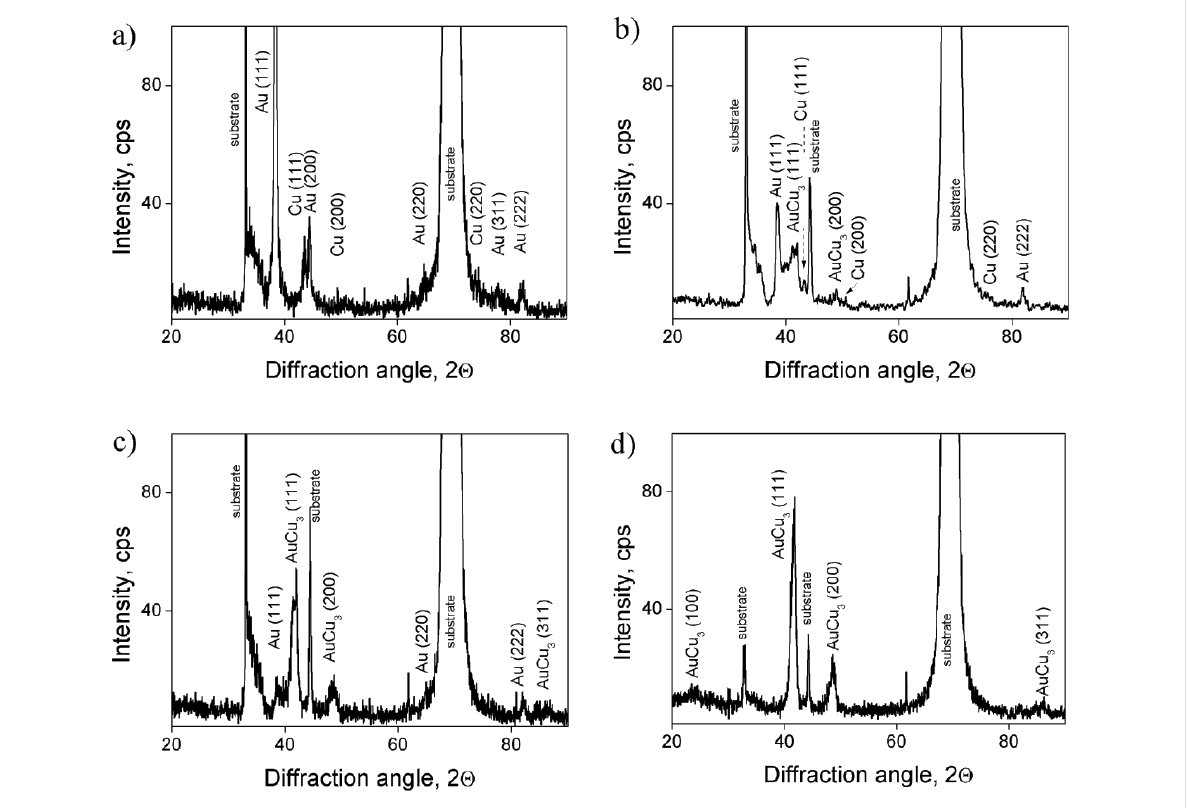
Figure 2: XRD θ –2 θ patterns of Au(25nm)/Cu(50nm) samples a) as deposited, b) annealed at 180 °C for 5 h, c) for 10 h and d) at 200 °C for 44 h.